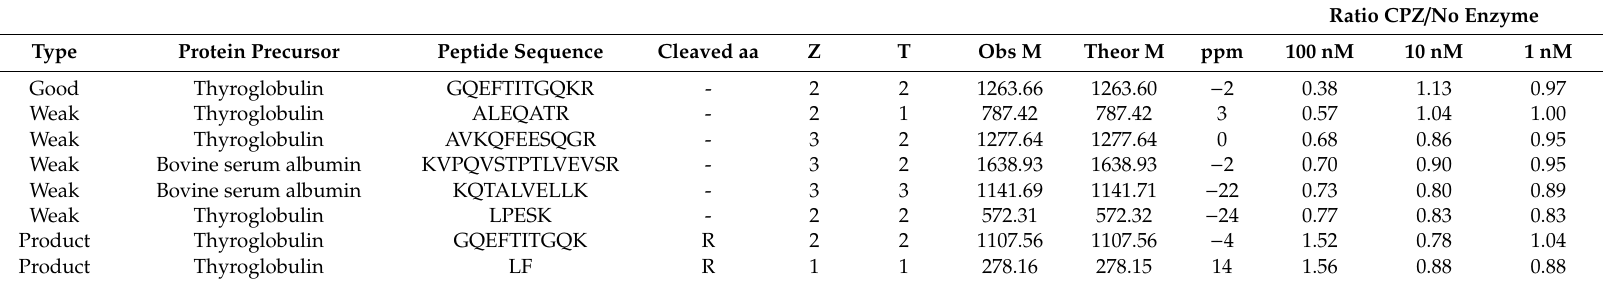
Table 4. Good substrates, weak substrates, and products of CPZ identified using the tryptic peptide